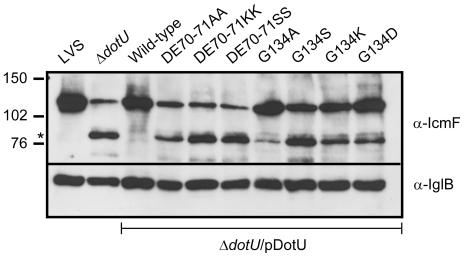
DotU impacts on IcmF/PdpB stability.Analysis of IcmF stability in a ΔdotU null mutant expressing GSK-tagged DotU and mutated variants thereof in trans. Proteins contained in inner membrane fractions were separated by SDS-PAGE and identified by immunoblot analysis using antiserum specific for IcmF/PdpB or the loading control IglB. The asterisks indicate IcmF degradation products that are formed in the absence of DotU or in the presence of specific DotU substitution mutants expressed in trans, and the corresponding sizes in kDa are indicated. Full-length IcmF is predicted to be a 127.5 kDa protein according to SAPS (www.ebi.ac.uk/Tools/saps/). The experiment was repeated at least two times and a representative example is shown.